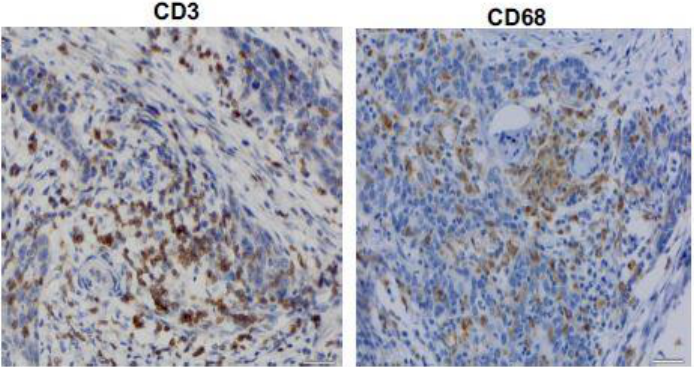
Figure 2. Representative expression status for CD3 + and CD68 + in high-grade non-muscle invasive bladder tumor. All images were captured at 400× magnification.